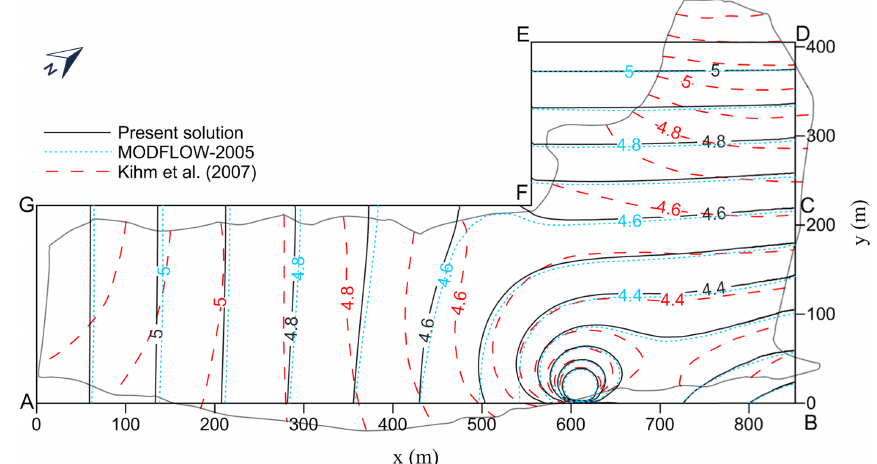
Figure 3. Contours of the hydraulic head in the L-shaped aquifer predicted by the present solution, MODFLOW, and FEM simulations with an irregular outer boundary reported in Kihm et al. (2007).